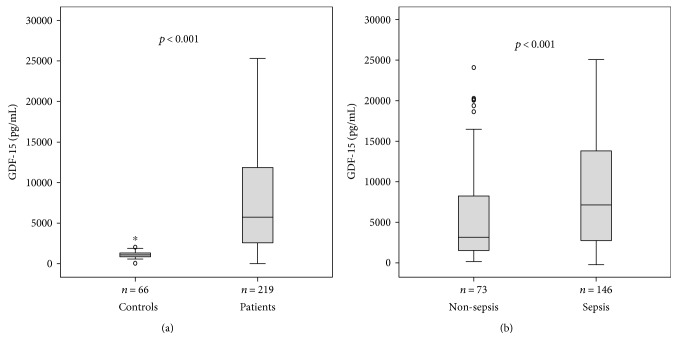
Serum GDF-15 concentrations in critically ill patients and sepsis. (a) Serum levels of GDF-15, at the time of admission to the ICU, were significantly higher in critically ill patients than in healthy controls (p < 0.001; U test). (b) GDF-15 levels were significantly higher in patients with sepsis (p < 0.001) compared to ICU patients without sepsis.